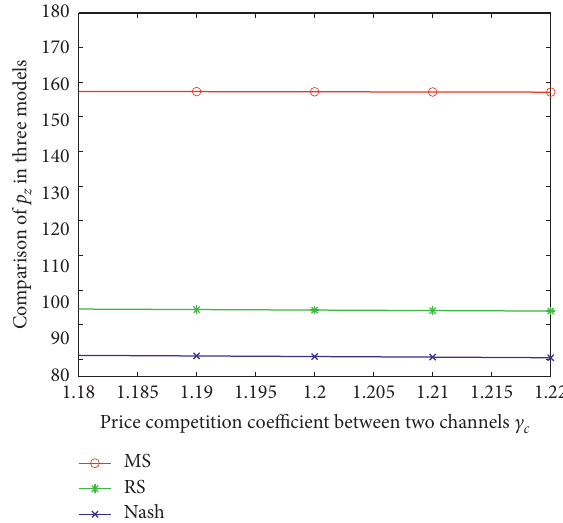
Figure 6: The comparison of the optimal retail price of standard products p r in the three models.